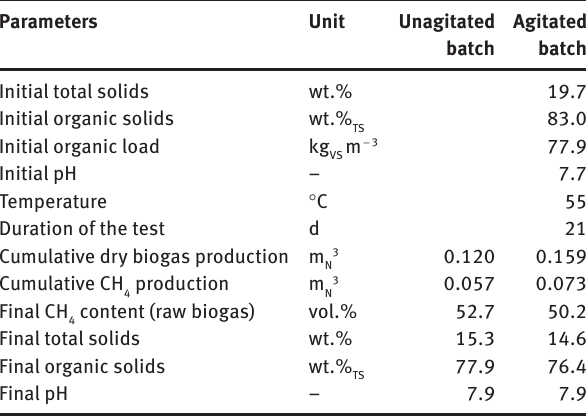
Table 2: Parameters of high-solids thermophilic anaerobic digestion.